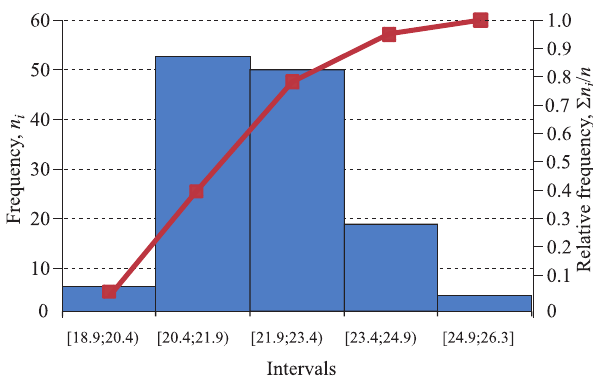
Fig. 6. Histogram of SZ values of resistance to fragmentation of crushed dolomite and distribution function